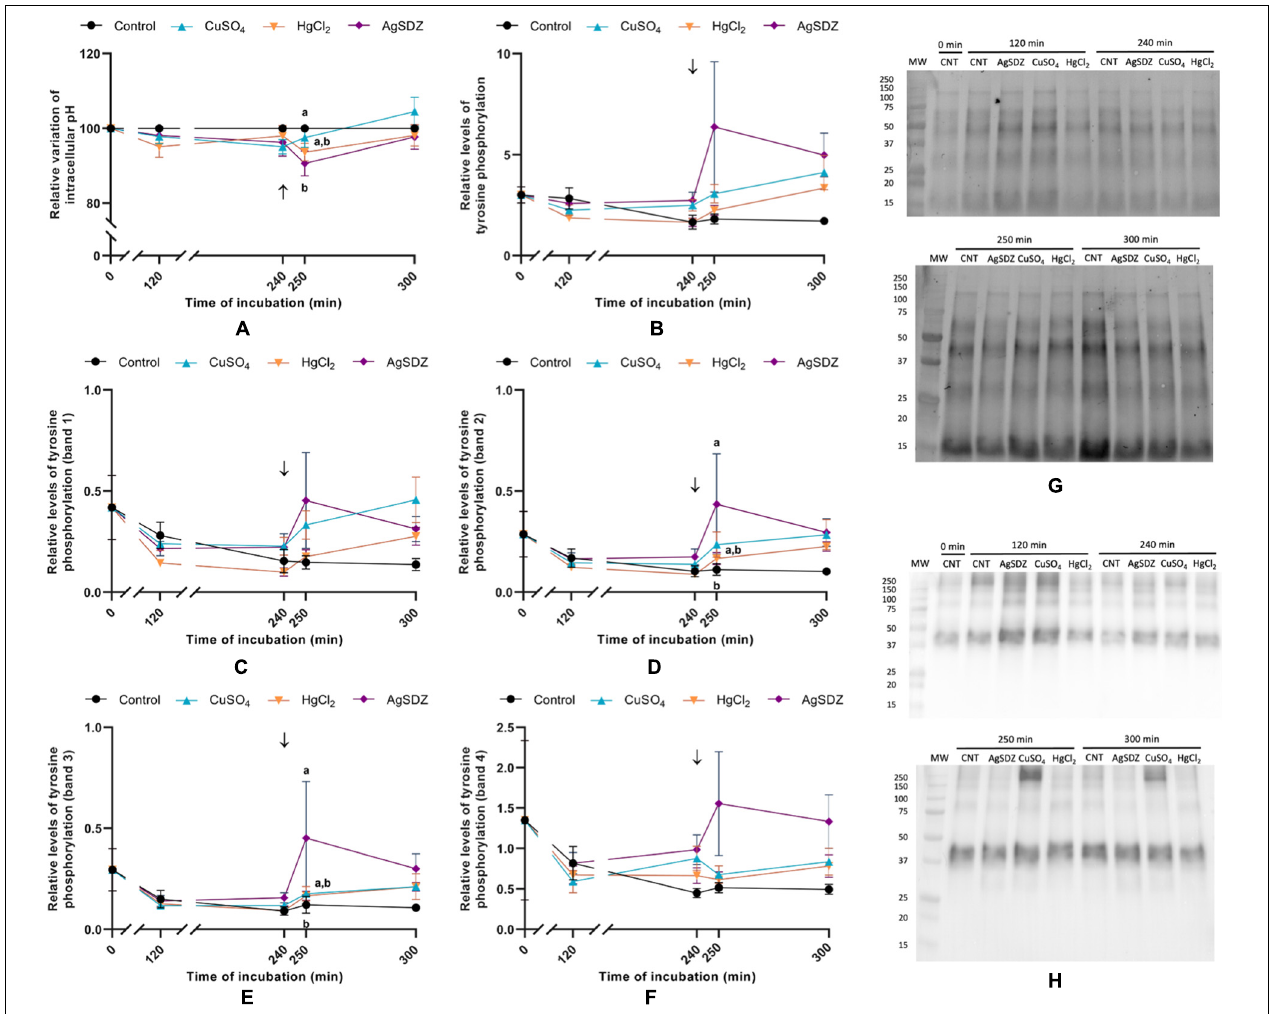
FIGURE 7 | Relative variation of pH and relative levels of tyrosine phosphorylation. (A) Intracellular variation of pH compared to the control sample; (B) relative levels of total tyrosine phosphorylation; (C) relative levels of total tyrosine phosphorylation from band 1 ( ∼ 200 kDa); (D) relative levels of total tyrosine phosphorylation from band 2 ( ∼ 175 kDa); (E) relative levels of total tyrosine phosphorylation from band 3 ( ∼ 75 kDa); (F) relative levels of total tyrosine phosphorylation from band 4 ( ∼ 40 kDa); (G) total protein measured through stain-free; and (H) immunoblotting showing the tyrosine phosphorylation pattern after the incubation with a 4G10 R (cid:13) Platinum, mouse monoclonal Anti-Phosphotyrosine Antibody [1:5,000; (v:v)] and rabbit anti-mouse, secondary antibody conjugated with HRP [1:10,000; (v:v)]. All parameters were measured in samples exposed to the presence or absence of different AQP inhibitors in the capacitation medium: cooper sulfate (CuSO 4 ), mercury chloride (HgCl 2 ) and silver sulfadiazine (AgSDZ). Data were collected after 0, 120 and 240 min of incubation in capacitation medium. At this point, progesterone was added to capacitation medium (arrow) and data were collected after further 10 and 60 min of incubation. Data are shown as mean ± SEM, and different letters (a,b) indicate significant differences ( P < 0.05) between different treatments within a given time